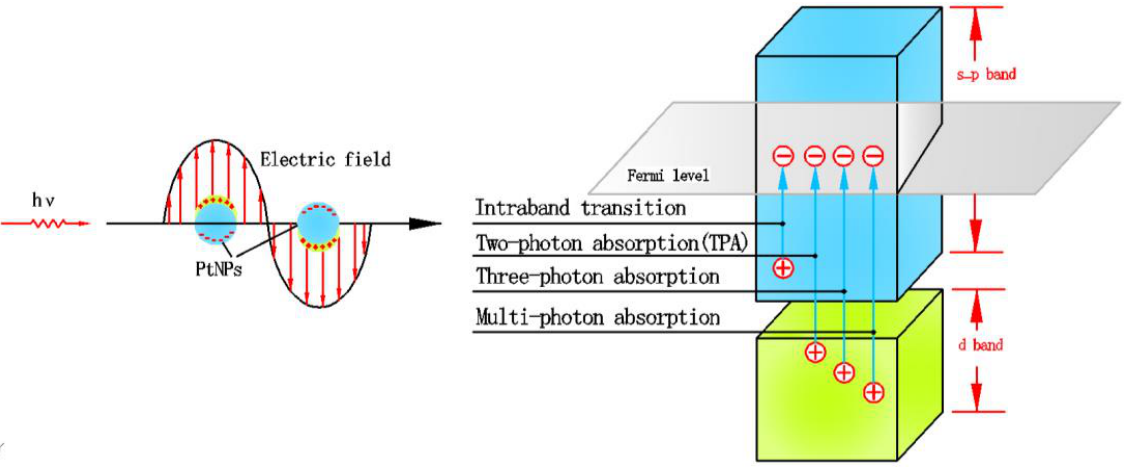
Figure 5. Schematic diagram of energy level transition of PtNPs.